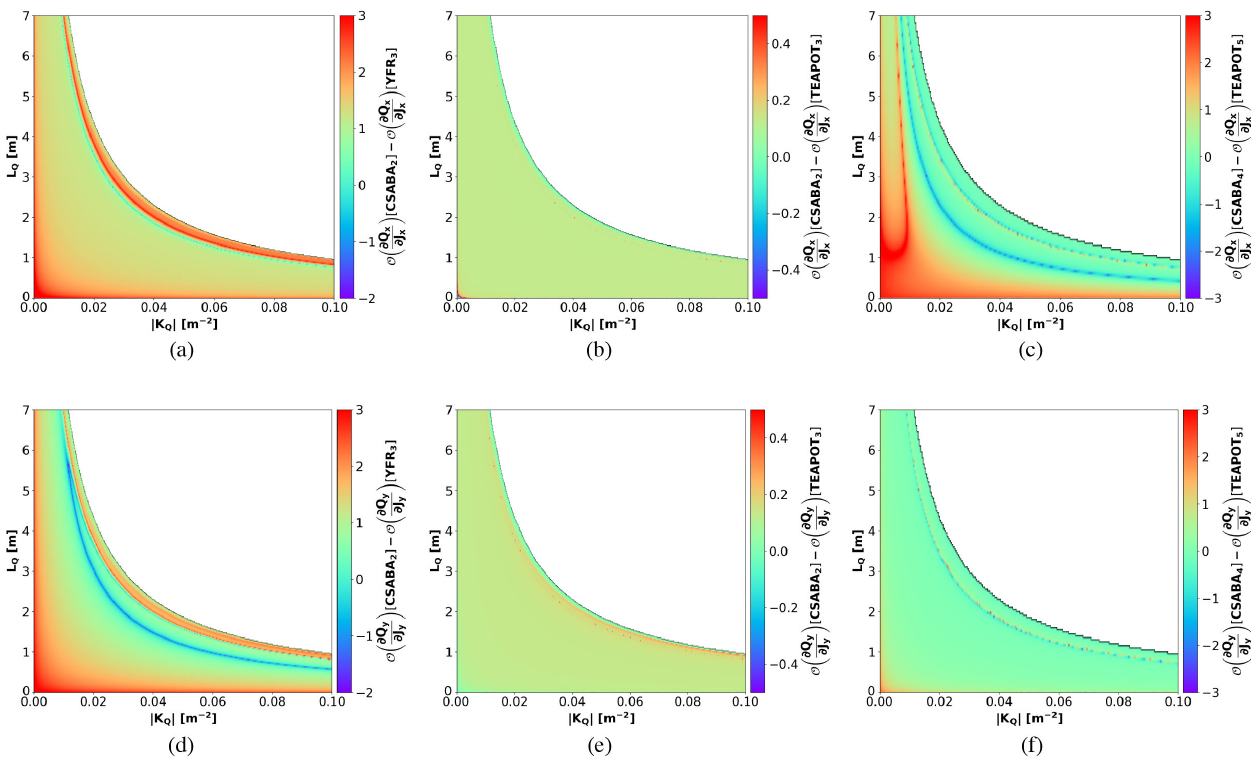
FIG. 4. The difference in order of accuracy of ∂ Q x TEAPOT 5 . The difference in order of accuracy of TEAPOT 5 . The combinations of ð K